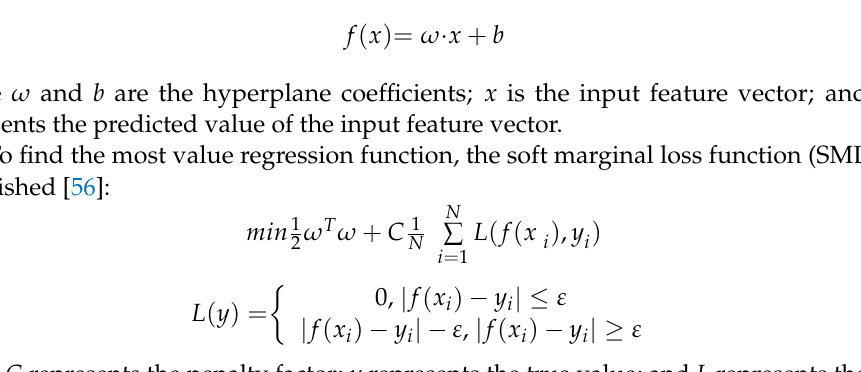
Figure 4. Hyperplane obtained in high dimension.